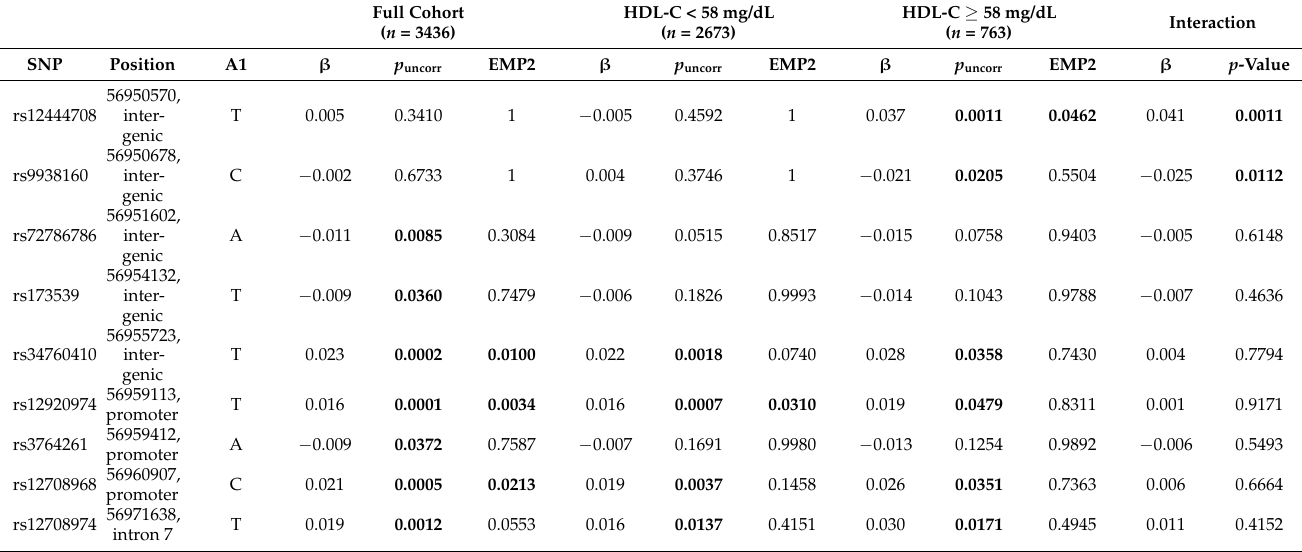
Table 2. Associations between single-nucleotide polymorphisms (SNPs) at CETP locus and cIMT max in the full IMPROVE cohort and in subjects stratified by HDL-C quartiles (pooled quartiles 1–3 vs. top quartile).